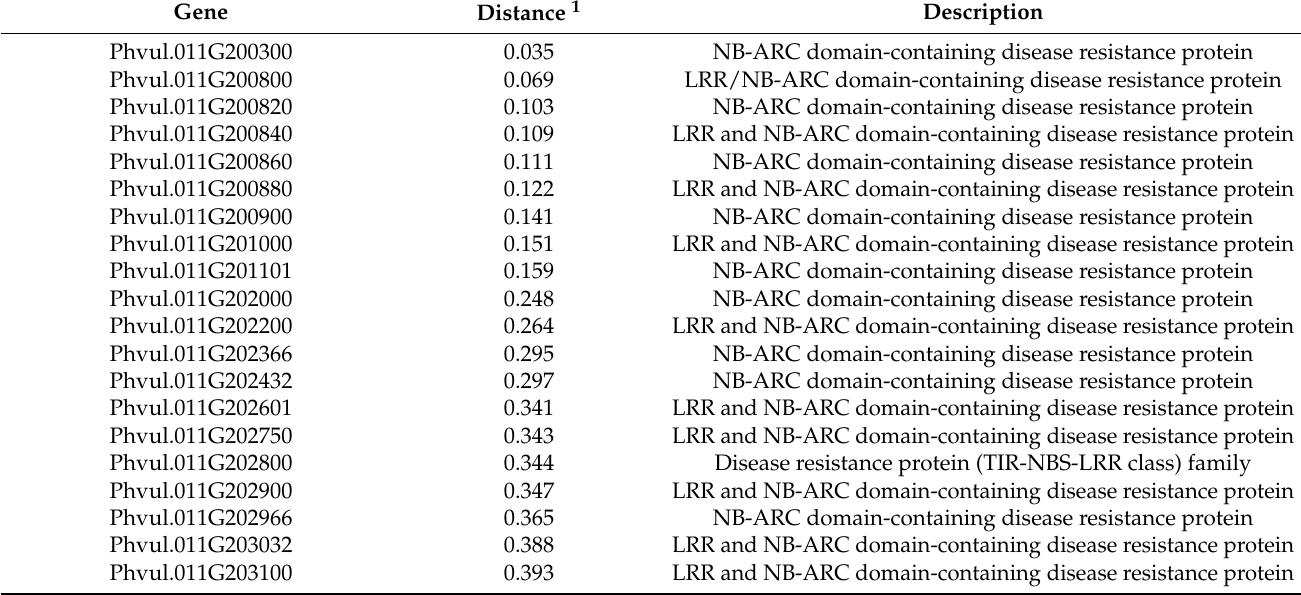
Table 4. Annotation of candidate genes with a confidence interval (0.464 Mb) of each significant SNP ss715648096 associated with the Fusarium wilt strain UFV01 for DSR ( p -value 5.27 × 10 − 10) and AUDPC ( p -value 2.59 × 10 − 5 ) for 205 common bean genotypes and 2001 SNPs: SNP’s positions in mega base pairs